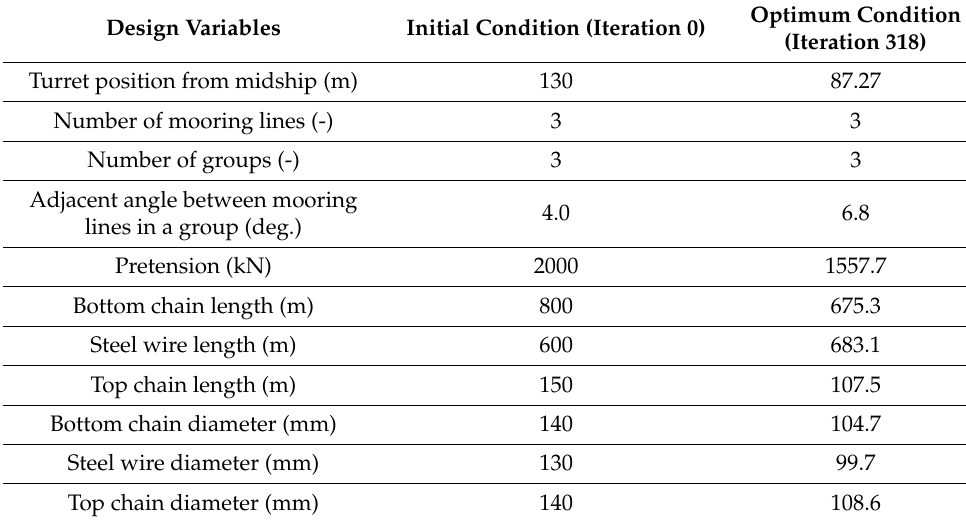
Figure 6. Optimized mooring line configuration ( left ) and its line characteristic ( right ), Case A. Table 5. The results of the mooring system optimization for case A.